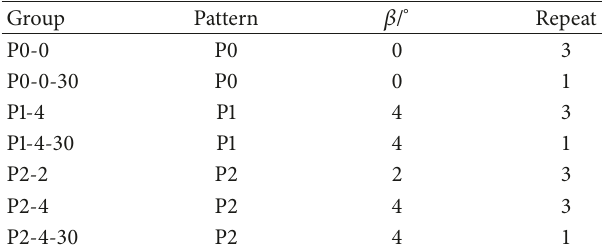
Table 3: Test groups and